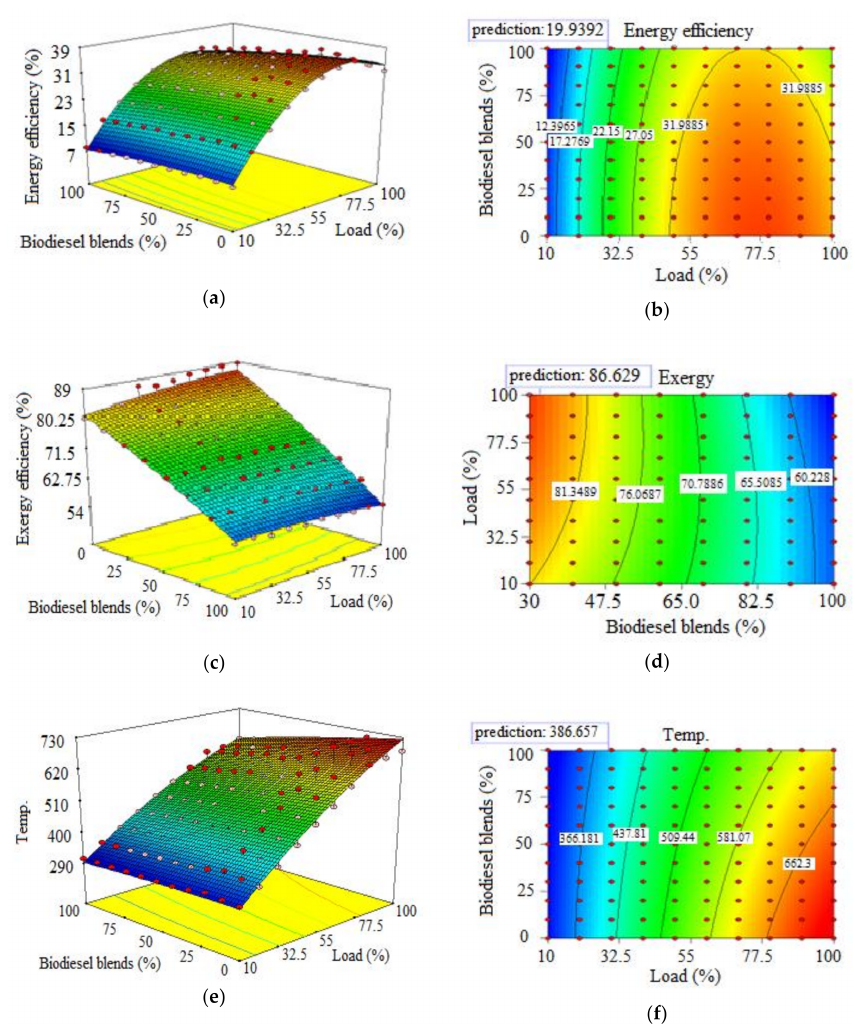
Figure 7. The optimum conditions for operating the engine based on energy and exergy efficiency for mathematical modeling. ( a ) Energy efficiency; ( b ) contours of Energy efficiency; ( c ) Exergy efficiency; ( d ) contours of Exergy efficiency; ( e ) Temperature; ( f ) contours of